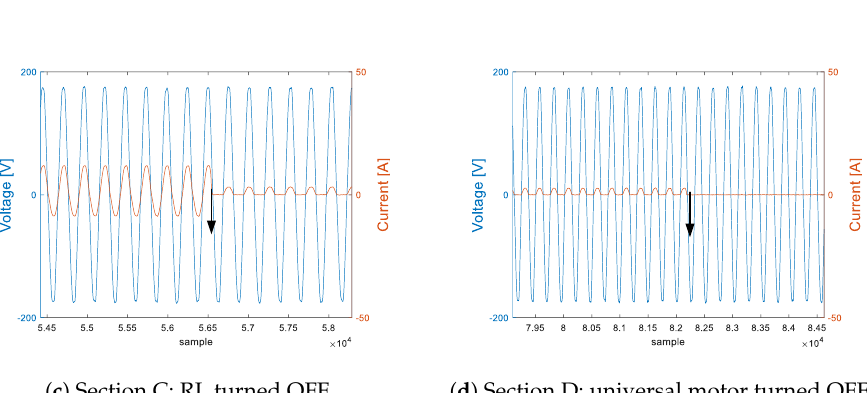
( c ) Section C: RL turned OFF. ( d ) Section D: universal motor turned OFF. Figure 21. Sections ( a – d ): RL and universal